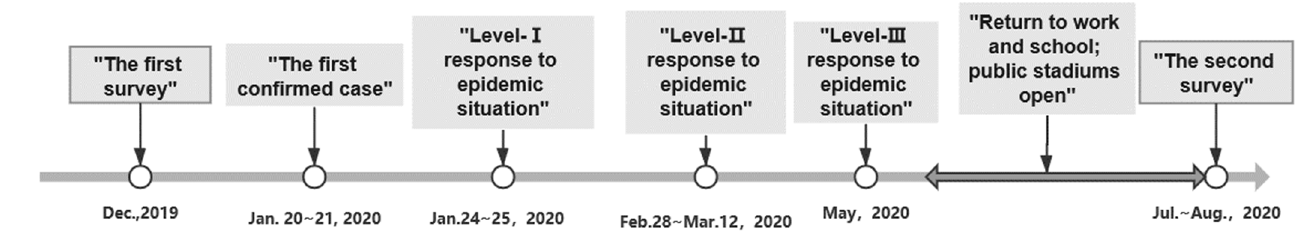
Figure 1. Flow chart of the survey distribution process. Notes: standards for response levels of Chinese public health incidents related to COVID-19: level I: in case of a particularly important public health emergency, the provincial head- quarters shall organize and coordinate emergency response work within the administrative area in accordance with the decision-making and unified command of the State Council. Level II: in case of an important public health emergency, the people’s governments at all levels of the incident shall organize and coordinate corresponding emergency agencies to carry out emergency response in accordance with the unified deployment of provincial headquarters. Level III: in case of a relatively important public health emergency, the relevant emergency command agencies of cities above prefecture level shall organize and coordinate relevant emergency response work.